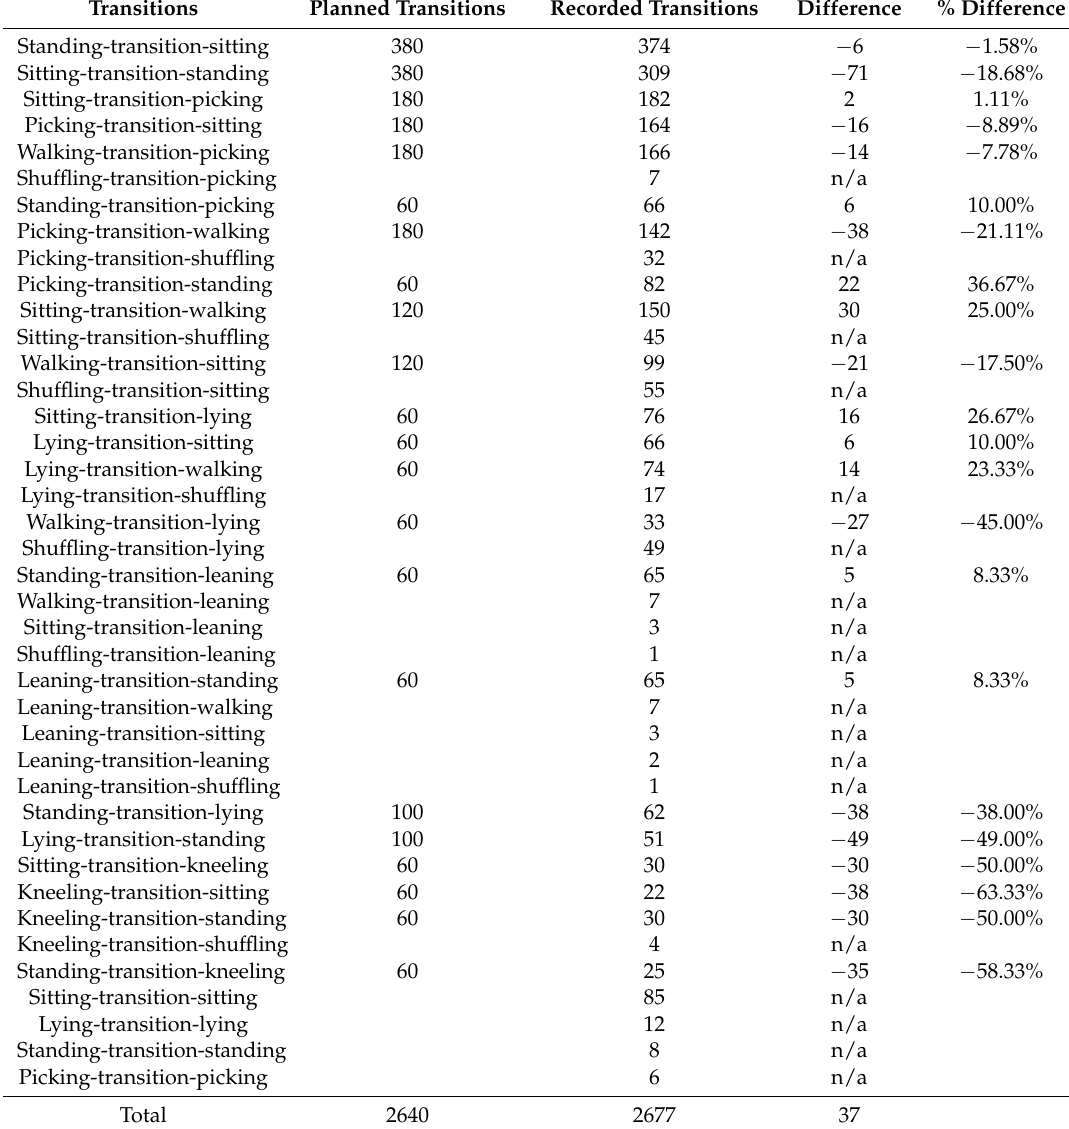
Table 8. In-lab transitions, the recorded transitions, the difference and the percentage difference. Transitions Planned